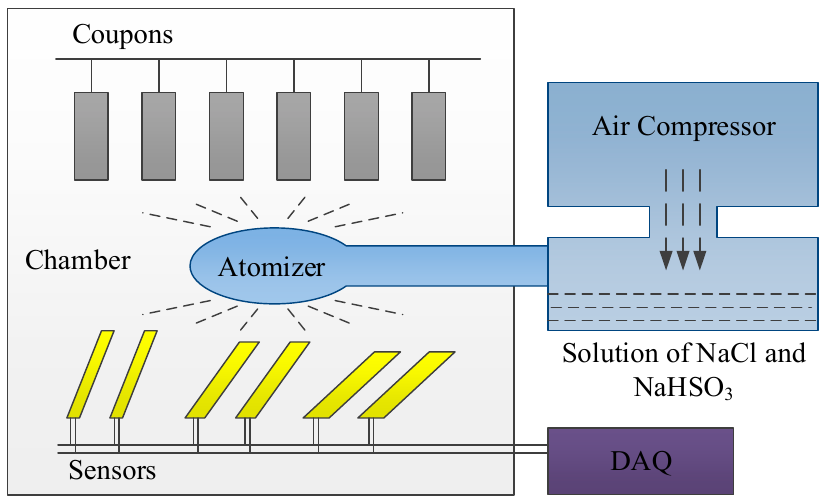
Figure 8. Platform and layout of the salt spray test.